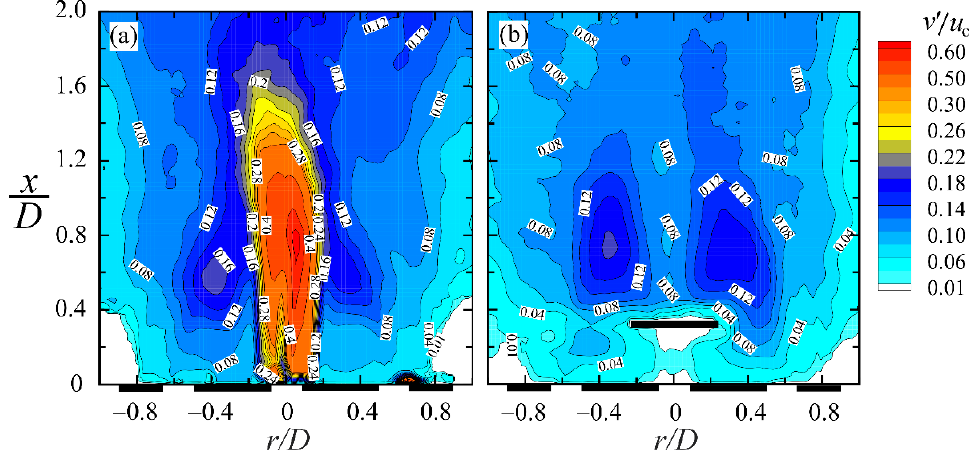
Figure 6. Radial fluctuation velocity contours of swirling double-concentric jets. Re c = 280, Re a = 480, and S = 0.432. ( a ) One centerbody, ( b ) two centerbodies.